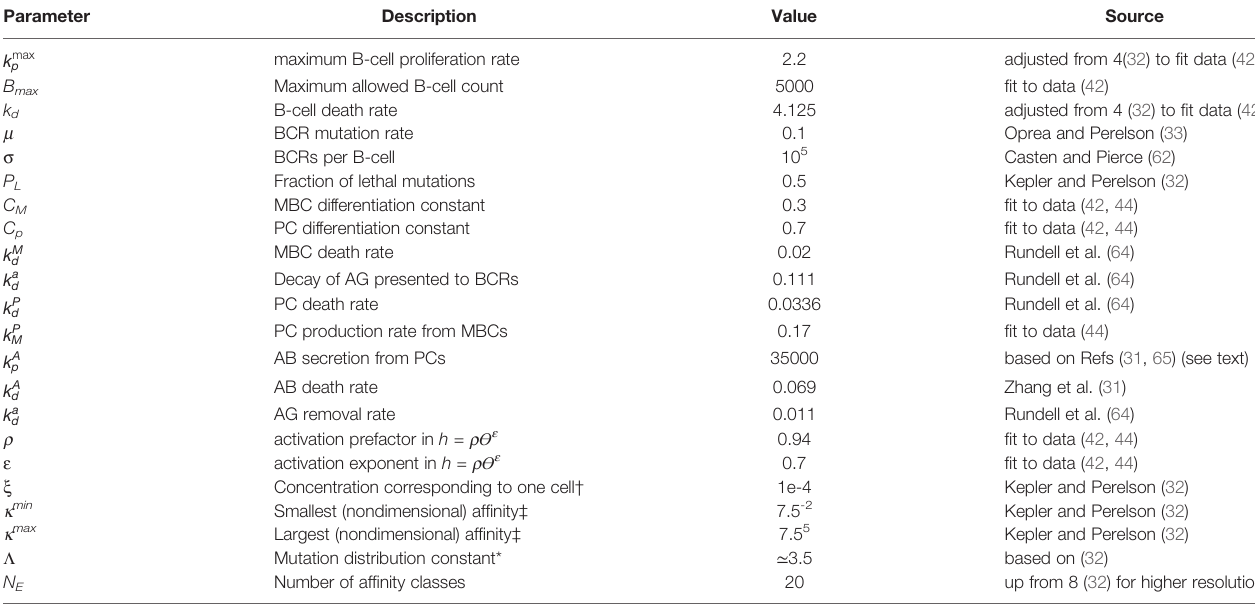
TABLE 1 | Model and simulation